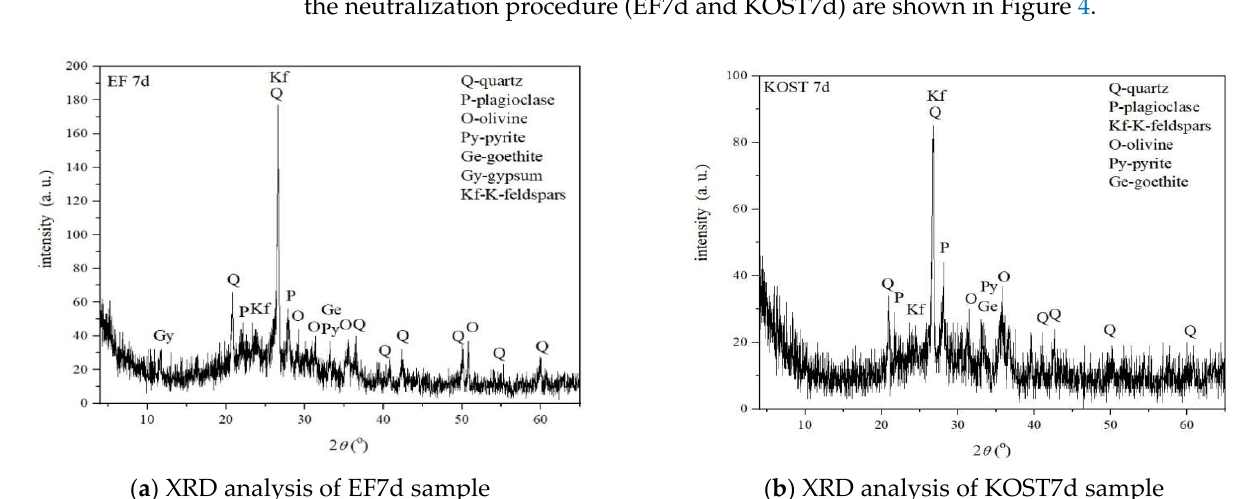
Figure 5. ANC test results of EF 7d and KOST 7d samples.